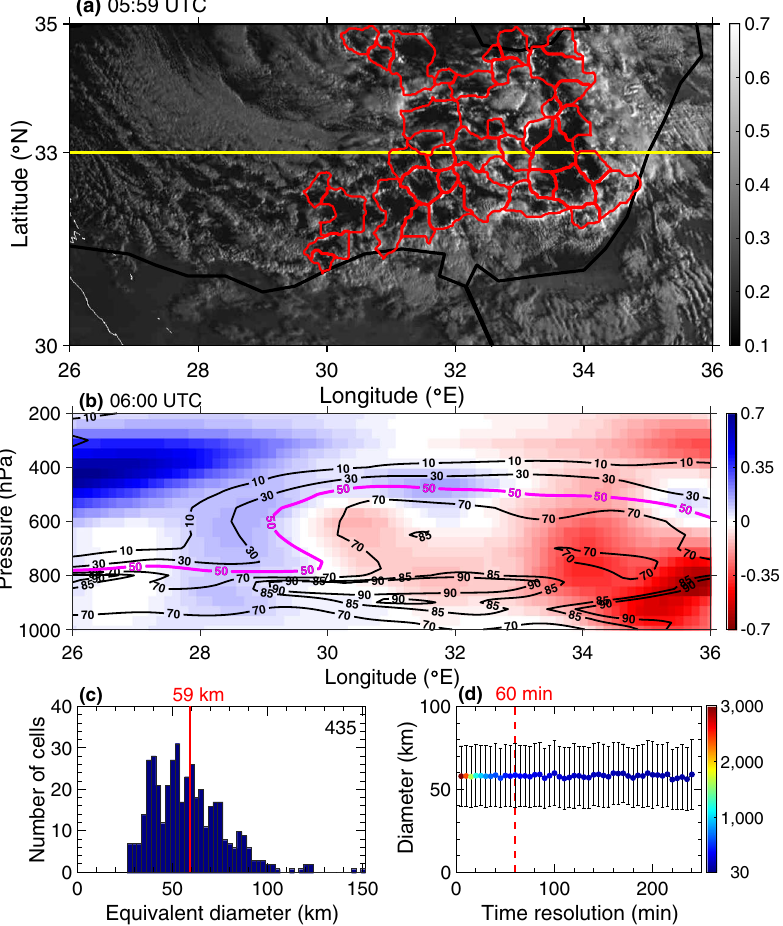
Fig. 1 Deep-open-cells in a Cyprus low event (26 January 2018). a 05:59 UTC, normalized re fl ectance image (HRV, color bar), the boundaries of the identi fi ed open cells are marked by the red lines. The thick black line indicates the coast. b 06:00 UTC, reanalysis ERA-interim data, presenting the vertical velocity in Pa s − 1 (color bar), and RH in % vertical cross-section (black contours) along 33°N (yellow line in panel a ). The magenta contour marks RH = 50%. c Histogram of open cells ’ equivalent diameter based on the HRV images at 05:59, 06:59, 07:59, 08:59, 09:59, 10:59, 11:59, 12:59, and 13:59 UTC. The red line indicates the average diameter (59 km). The black number at the top right indicate the total number of samples (435). d The average diameter of open cells as a function of sampling time (from 5 to 240 min, in 5 min intervals). The colors denote the number of samples, the error bars represent ±1 standard deviation, and the dashed red line marks the sampling time presented in panel c (1